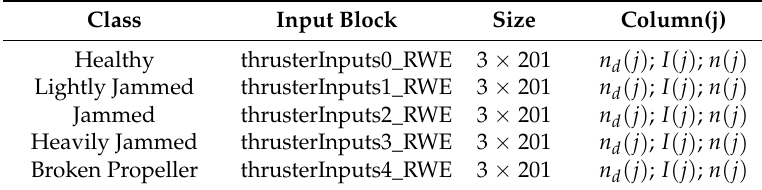
Table 6. Structure of the input training data set thrusterInputs_RWE.